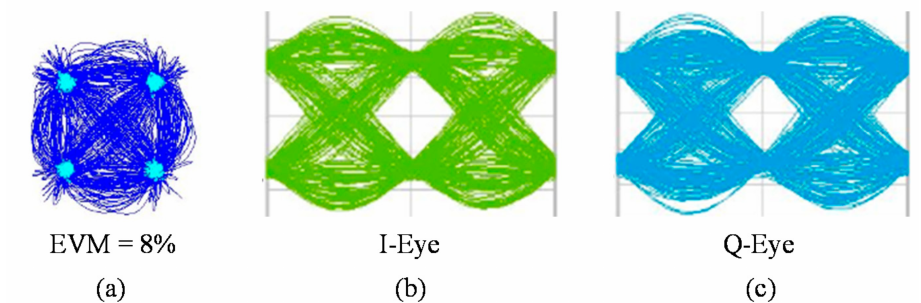
Figure 12. Demodulation of the QPSK up-converted signal at BR = 0.5 Gbit/s at the mixing frequency of 39.5 GHz. ( a ) constellation diagram with EVM = 8%, ( b ) I-eye diagram, and ( c ) Q-eye